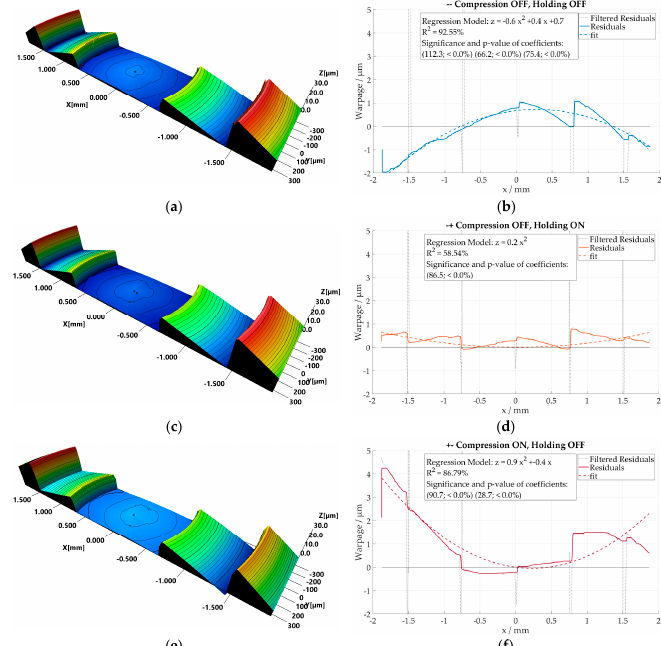
Figure A1. On the left, 3D view of the lens’ central location, sampled as shown in Figure 5. On the right, the residuals of the respective x profiles in comparison with nominal geometry, sampled in the image center. The following process conditions are considered for the COP material results: ( a , b ) IM without holding; ( c , d ) IM; ( e , f ) ICM without holding; ( g , h )